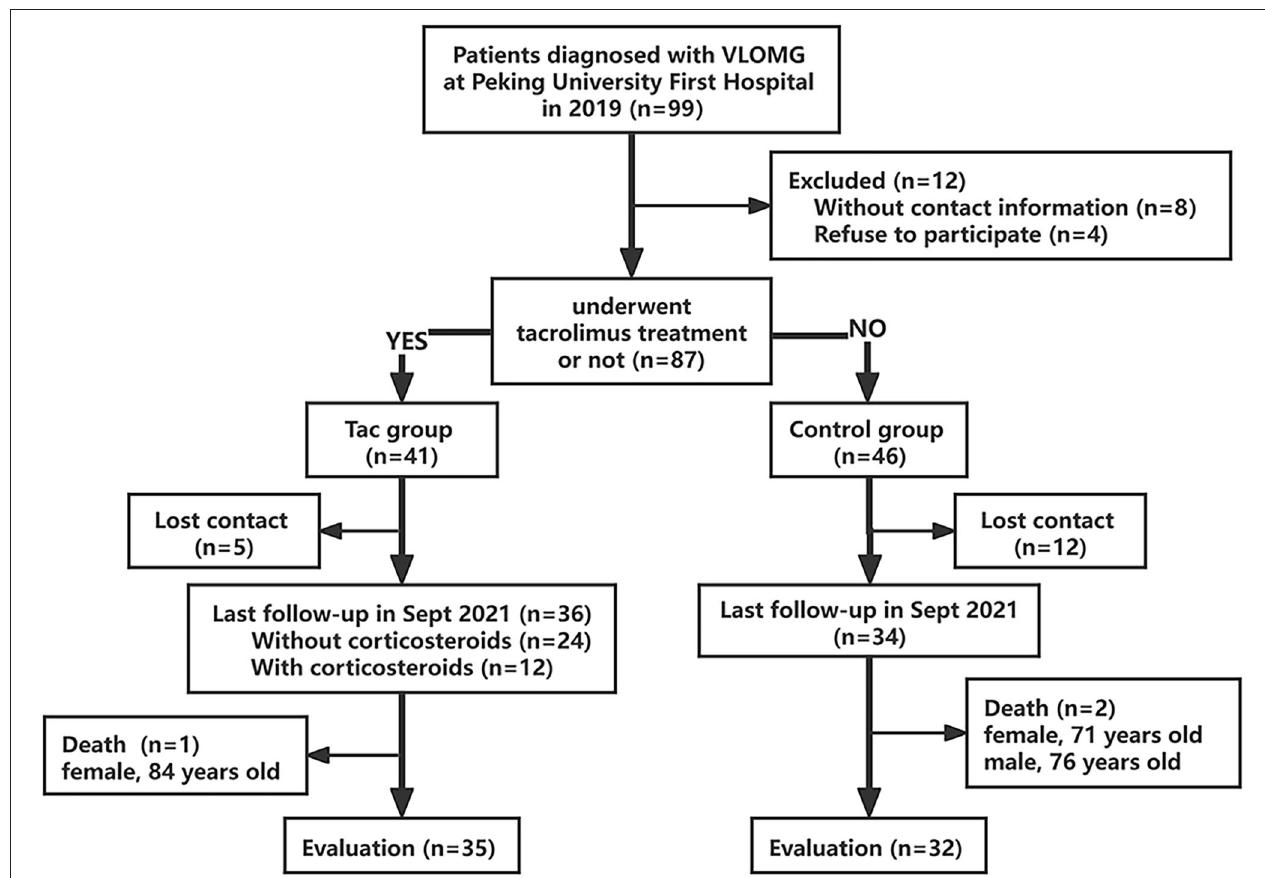
FIGURE 1 | Flowchart of the participants included in this study. VLOMG, very-late-onset myasthenia